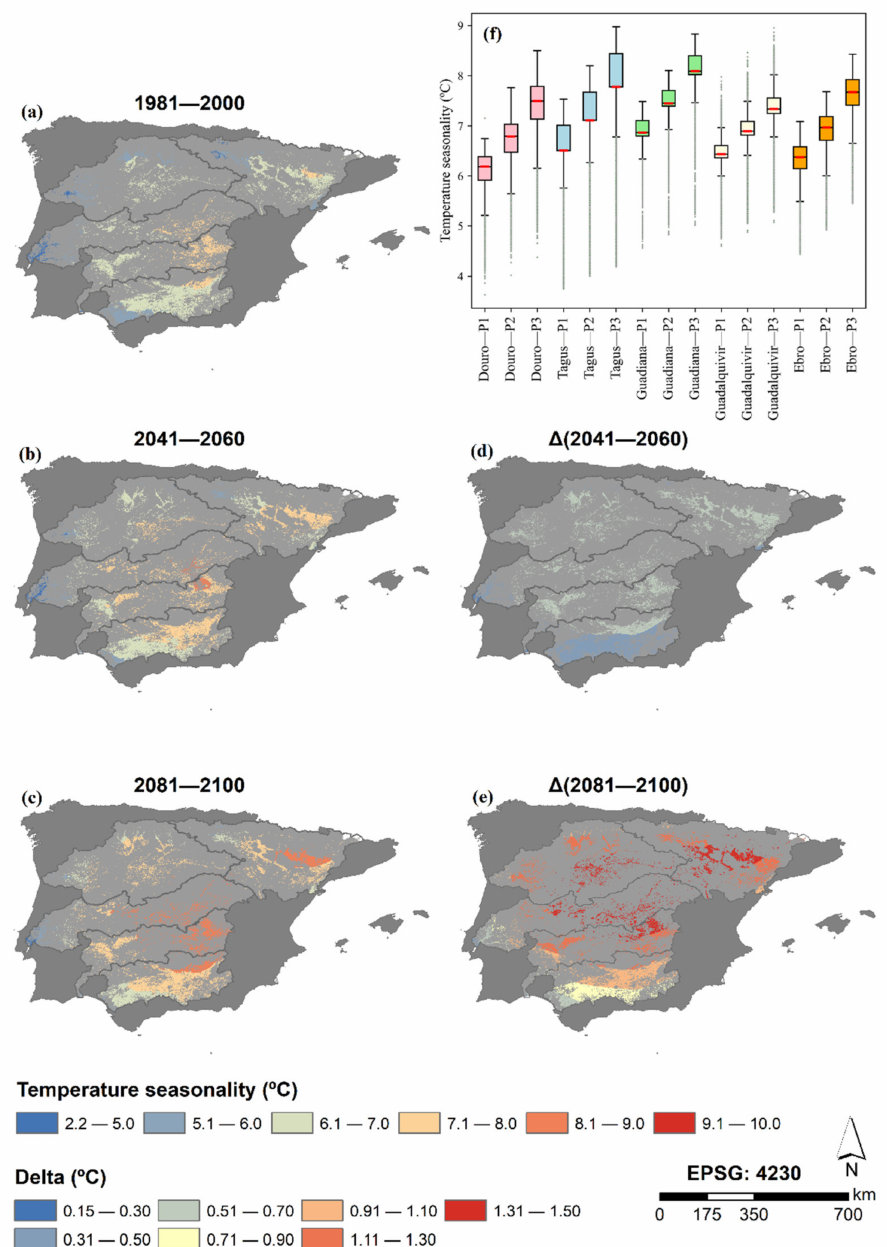
Figure 5. Temperature seasonality (in ◦ C) in water-dependent areas in the Iberian Peninsula for: ( a ) historical period 1981–2000 (P1), ( b ) 2041–2060 (P2), and ( c ) 2081–2100 (P3), ( d ) P2–P1, ( e ) P3–P1, and ( f ) locality, spread, and skewness for each period and river